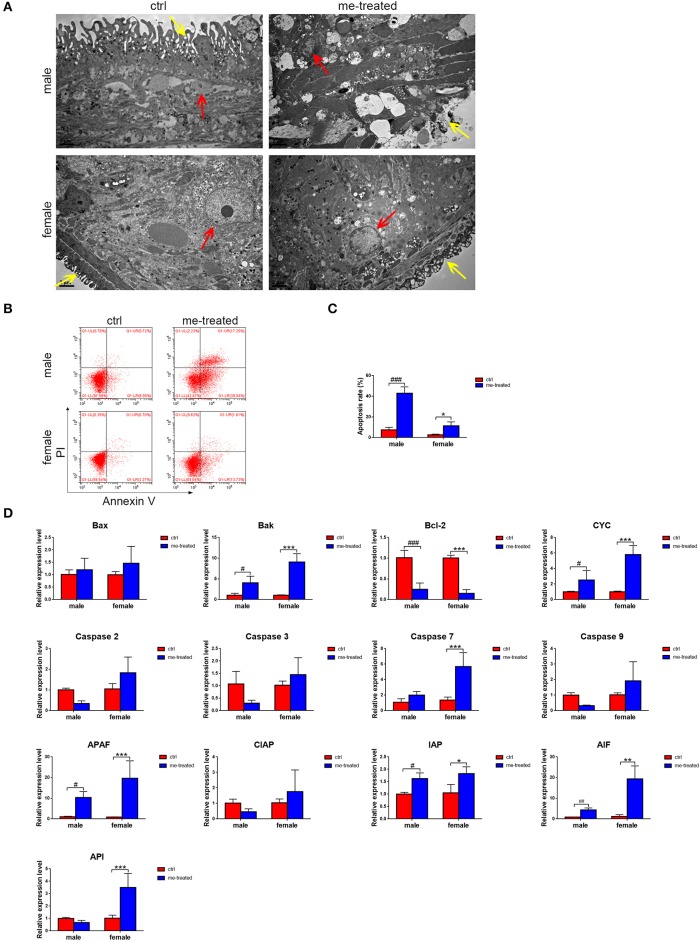
Myricetin induces the apoptosis process and destroy the tegument architecture of S. japonicum adult worms in vitro. (A) Adult worms following treatment with myricetin were observed by transmission electron micrographs (TEM). The yellow and red arrows indicate tegument and cell nucleus, respectively. (Scale bars: 2 μm) (B) Apoptosis induced with myricetin was detected using Flow cytometry in worms. (C) Apoptosis induced with myricetin was statistical analyzed in worms. (D) Relative expression levels of 13 apoptosis associated genes after treatment with myricetin measured by Real-time qPCR. Data were shown as the means ± SD. #P < 0.05, ##P < 0.01, ###P < 0.001, compared with the negative ctrl group of male worms; *P < 0.05, **P < 0.01, ***P < 0.001, compared with the negative ctrl group of female worms. Data are representative results from at least 15 worms investigated in three independent experiments. ctrl, adult worms were incubated in RPMI 1,640 medium with 1% DMSO; me-treated, adult worms treated with myricetin.